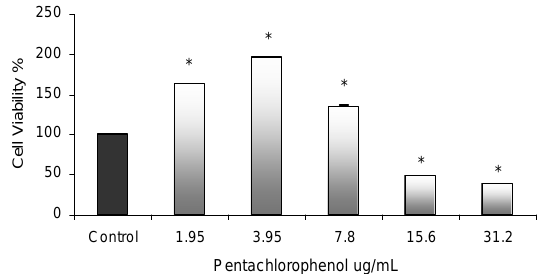
Figure 1. Toxicity of pentachlorophenol on AML 12 mouse hepatocytes . The cells were treated with serial dilutions (0-31.2µg/mL) of PCP. methodology